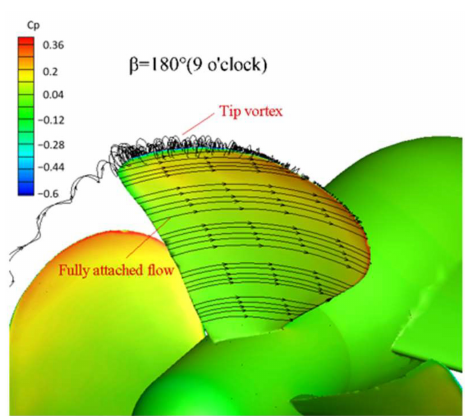
Figure 19. Streamline at tip of paddle.